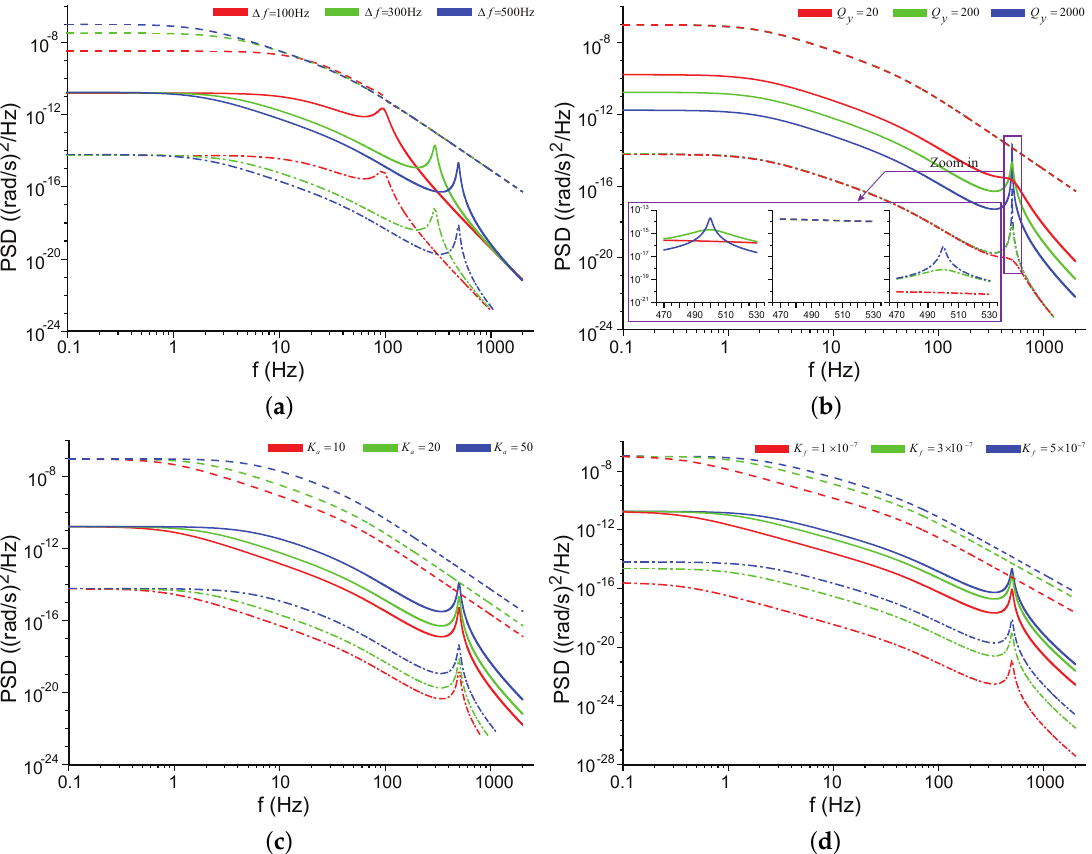
Figure 11. The PSD of the NER for different parameters in force-rebalance mode-split gyroscopes. Solid lines for the mechanical NER. Dashed lines for the pickoff electrical NER. Dot-dashed lines for the feedback electrical NER. ( a ) Comparisons between different modal frequency splits; ( b ) Comparisons between different Q y ; ( c ) Comparisons between different gains of the signal conditioning circuit; ( d ) Comparisons between different gains of the feedback forcer.